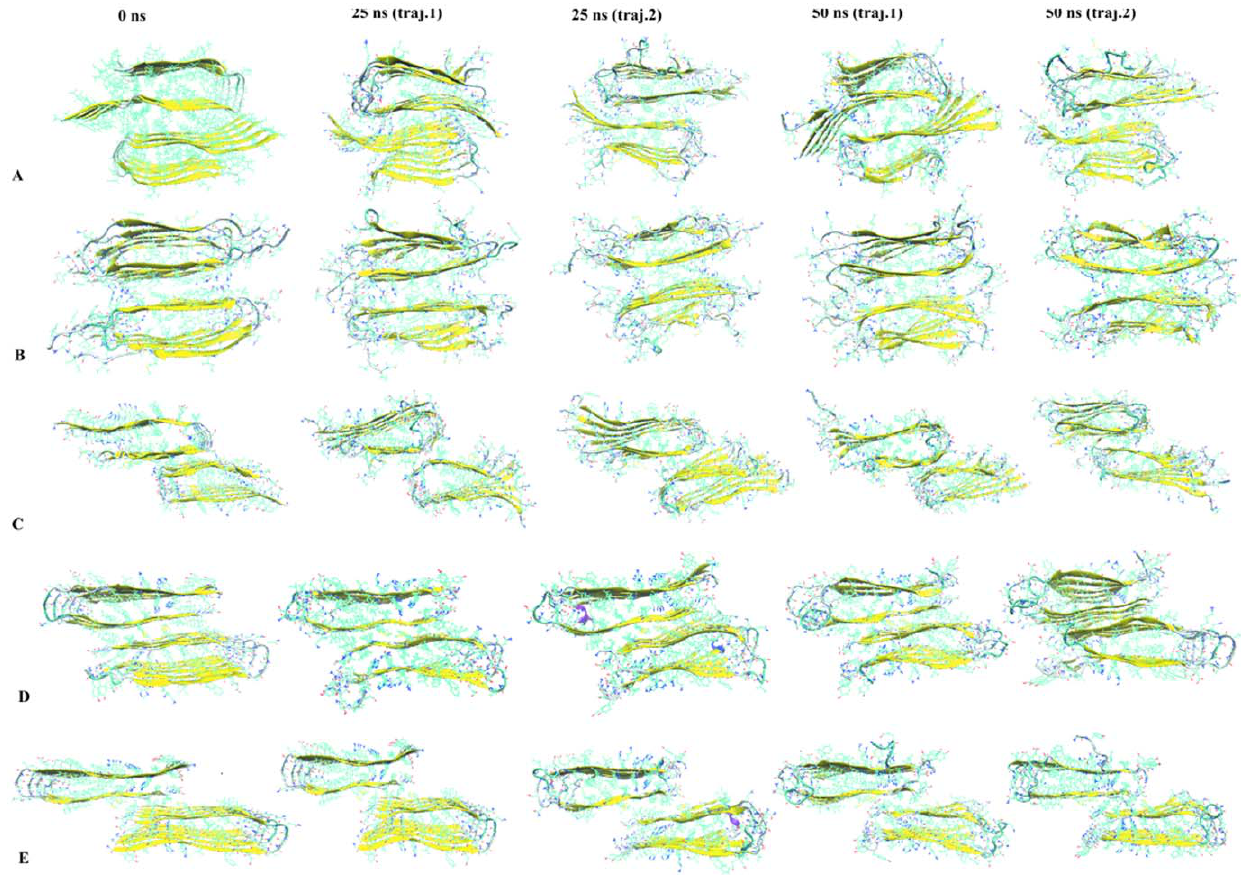
Figure 11. Snapshots from MD simulations for double-layered A b segmental polymorphism models with the steric zipper interfaces. (A) A b 16 2 21 P, (B) A b 16 2 21 AP (C) A b 27 2 32 , (D) A b 35 2 42 and (E) A b 130 2 42 interfaces at 0ns, 25ns and 50 ns.